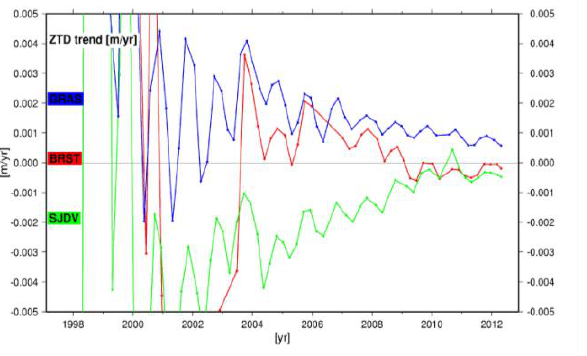
Figure 3. ZTD trend in m/yr for stations BRST, GRAS and SJDV from a simple linear fit through the unfiltered ZTD